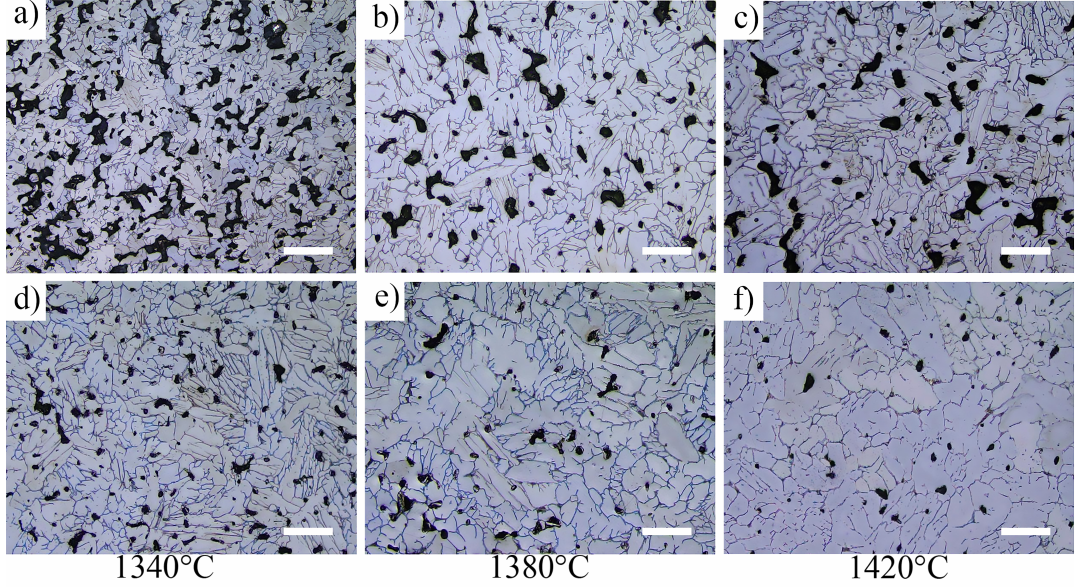
Figure 9. Microstructures of the sintered samples sintered with pure powder and mixed powder at di ff erent temperatures: ( a – c ) pure powder; ( d – f ) mixed powder. Scale bar = 100 µ